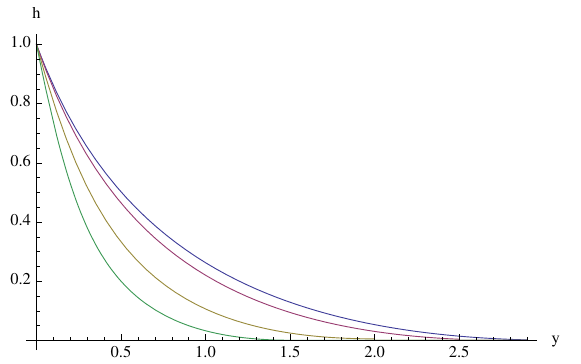
Figure 6 . Pro(cid:12)le function of charge one BPS baby Skyrmions for the baby potential (cid:22) = (cid:21) = 1 and (cid:3) = 1 for di(cid:11)erent values of gravity constant: (cid:20) 2 = 0 ; (cid:20) 2 = 1 ; (cid:20) 2 = 2 and maximal (cid:0) (cid:20) 2 = 3 : 65 | lines: blue, red, yellow and green respectively.